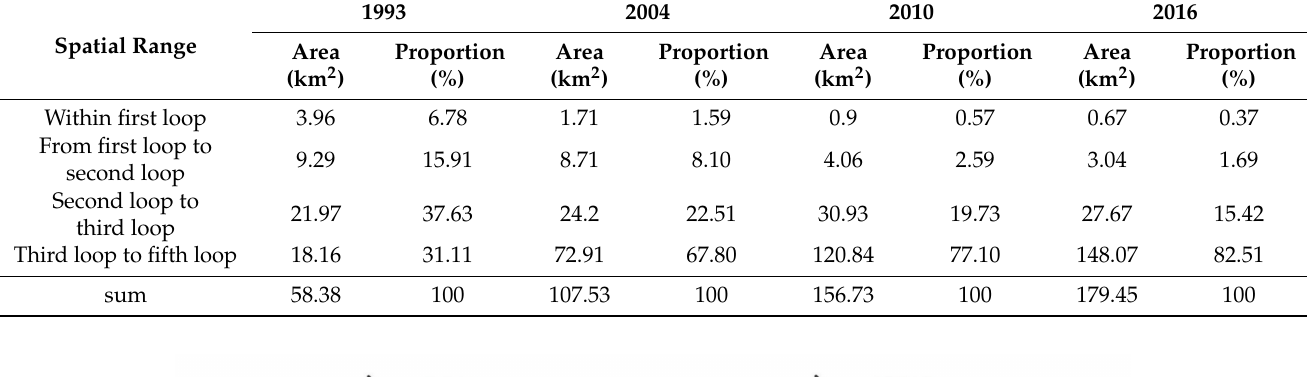
Table 2. Change of manufacturing land in the Wuhan metropolitan area since the 1990s.